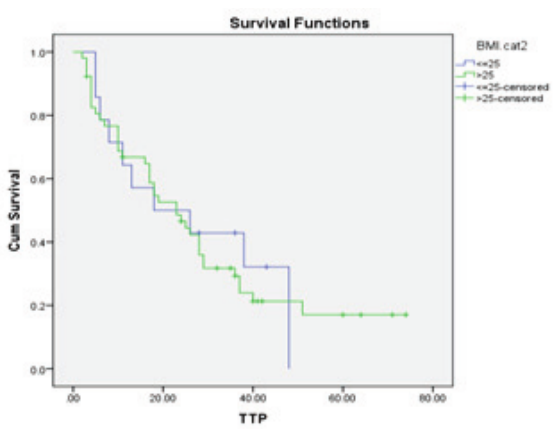
Figure. 2: Kaplan Meier curves showing time to progression of patients with BMI ≤25 and those with BMI >25